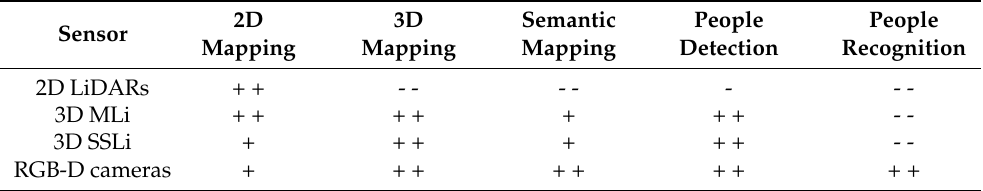
Table 5. Recommendations for sensor